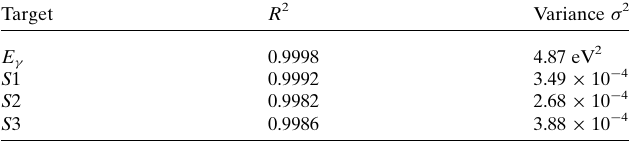
Table 4 Properties of the model’s predicted beam characteristics. The regression scores are based on the scaled predicted values and the variance scores are computed from the unscaled predicted